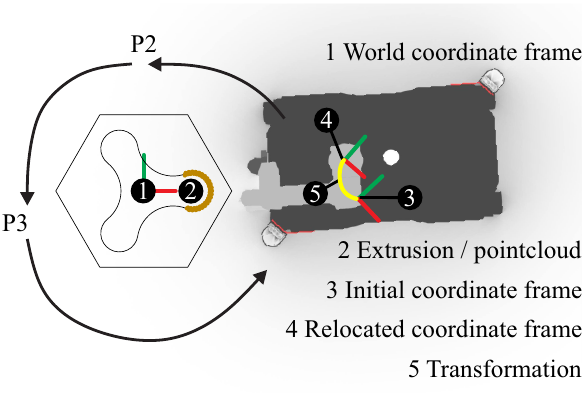
Figure 3. Mobile robot printing workflow with circular positioning around the column and the robot’s coordinate frames before and after repositioning at the same location.